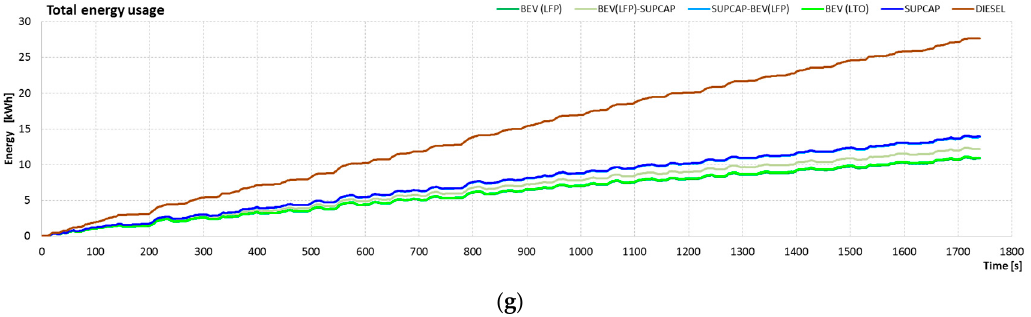
Figure 21. BCDC results of simulation tests, where: ( a ) Bus speed during tests (km/h); ( b ) Voltage and Current on DC-link (V), (A); ( c ) Motor/Engine Power (kW); ( d ) Battery & SUPCAP State of Charge (%); ( e ) Battery & SUPCAP temperature (°C); ( f ) Instantaneous energy consumption (Wh/km); ( g ) Total energy usage (kWh).